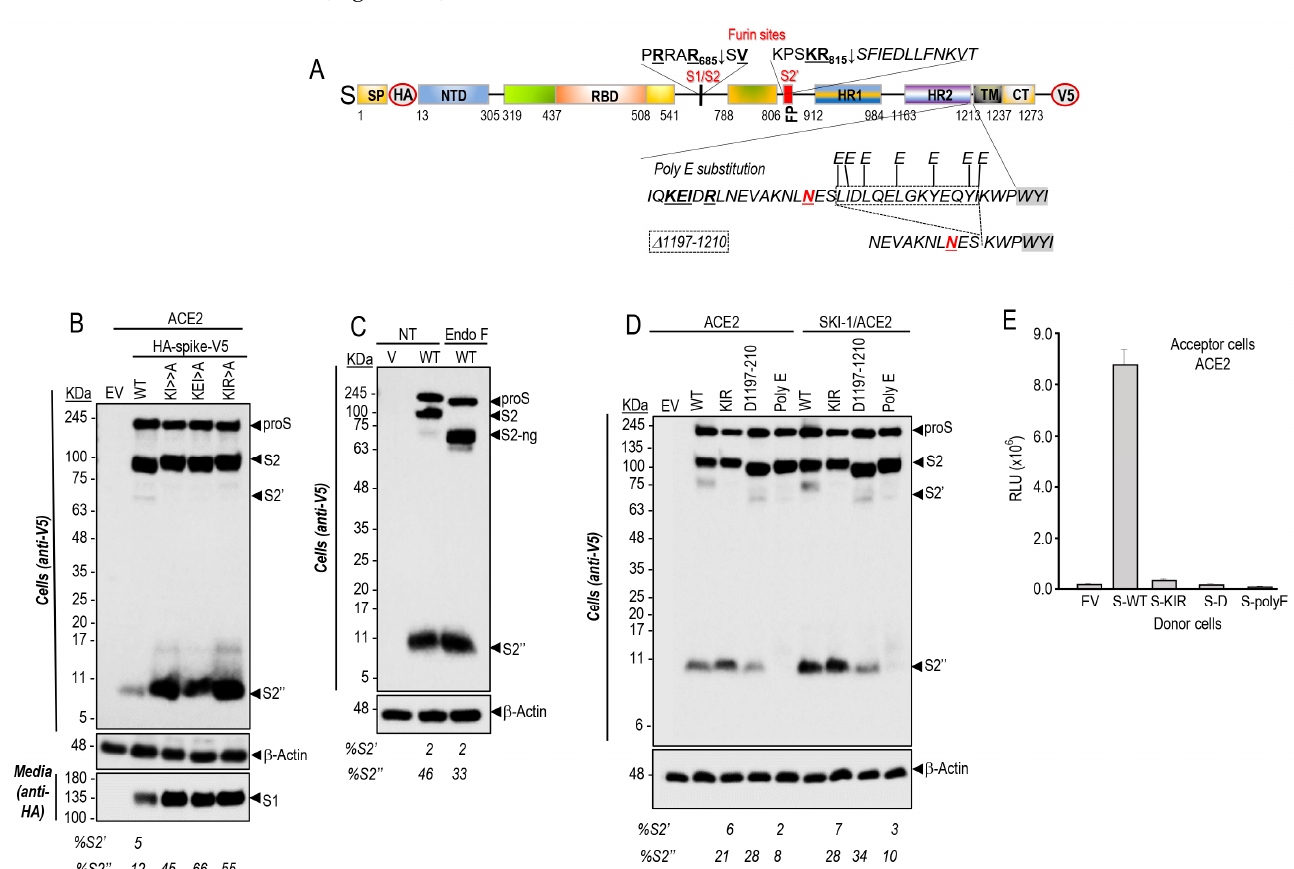
Figure 4. Identification of a potential shedding site of spike glycoprotein. ( A ) Schematic representa- tion of the primary structure of preproS showing WT sequence and the mutants of the C-terminal of HR2 domain. ( B ) Western blot analyses of HeLa cells following co-transfection with cDNAs coding for ACE2 and either WT-S-protein or its mutants: double KI (K1181A + I1183A) or triples KEI (K1181A + E1182A + I1183A), and KIR (K1181A + I1183A + R1185A) mutants. Note that mutants significantly enhanced the generation of S2” accompanied by the loss of S2 ′ . ( C ) Extracts from HeLa cells transfected with empty vector (EV) or V5-tagged wild type spike-protein (WT) were treated with Endo-F or mock treated (NT) and analyzed by Western blot using anti-V5 antibody. Note the molecular shift of non-N-glycosylated forms (ng) proS, S2 and S2 ′ but not that of S2” fragment after endo-F treatment. ( D ) Western blot analysis using mAb-V5 of cell lysates from HeLa cells expressing ACE2 with empty vector (EV), wild type spike-protein (WT), or its mutants: KIR (K1181A + I1183A + R1185A), ∆ -S ( ∆ 1197-1210), or poly E substitution in the absence or presence of SKI-1. ( E ) Cell-to-cell fusion assay of donor HeLa cells expressing either empty vector (EV), wild type spike-protein (WT), or its mutants: KIR, ∆ -S, or poly E substitution with acceptor cells expressing ACE2 receptor. All the mutants in the HR2 domain abrogate cell-to-cell fusion.